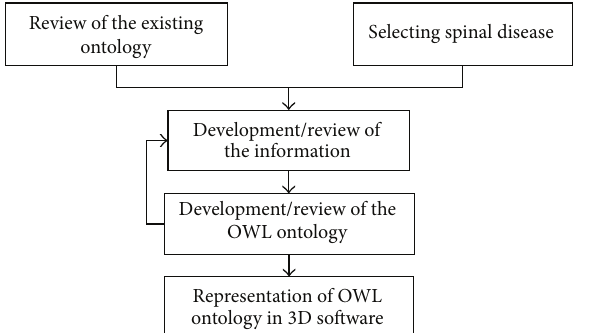
Figure 1: Process of building spine ontology.